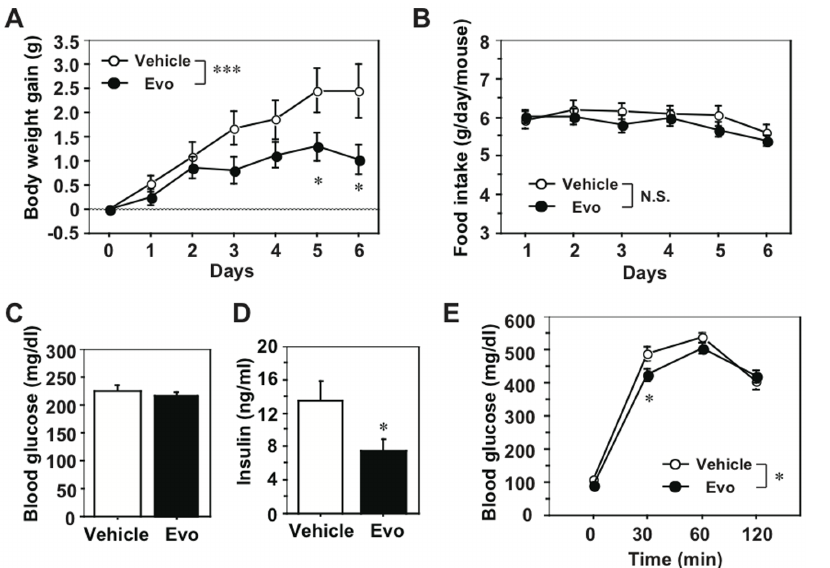
Figure 1. Effects of evodiamine on body weight, food intake, blood parameters and glucose tolerance in KK-Ay mice. Eight-weeks old female KK-Ay mice were injected i.p. daily with evodiamine (3 mg/kg body weight) or vehicle for 1 week. A, Body weight gain; B, food intake; C, fed glucose level; D, insulin level; E, IPGTT. After starvation for 17 h, mice were injected i.p. with glucose (1.5 mg/g body weight). Data are expressed as mean 6 SEM; n =14 and 13 for body weight gain and food intake; n =8 each for glucose and insulin levels; n=9 and 8 for IPGTT, in vehicle and evodiamine groups, respectively. * p , 0.05, *** p , 0.001 vs. vehicle group.